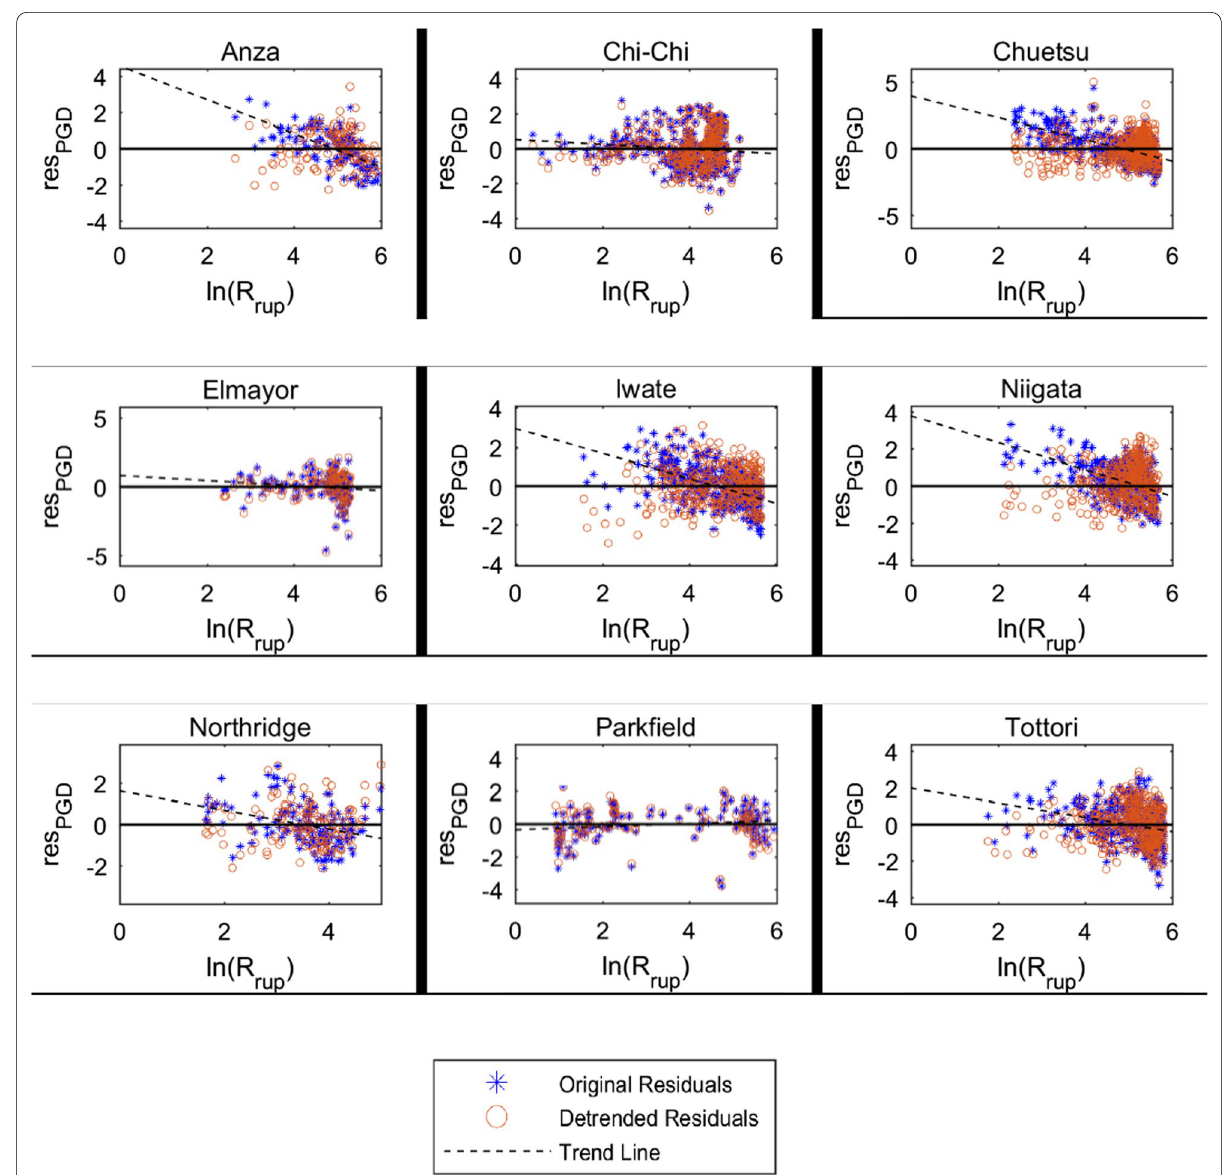
Fig. 8 Original and detrended residuals of PGD of selected earthquakes calculated by CB08